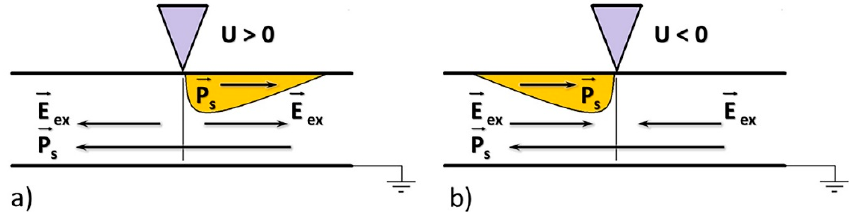
Figure 8. Schematic images of local polarization reversal. Local polarization reversal on a nonpolar cut by ( a ) positive and ( b ) negative voltage pulses applied to the probe.